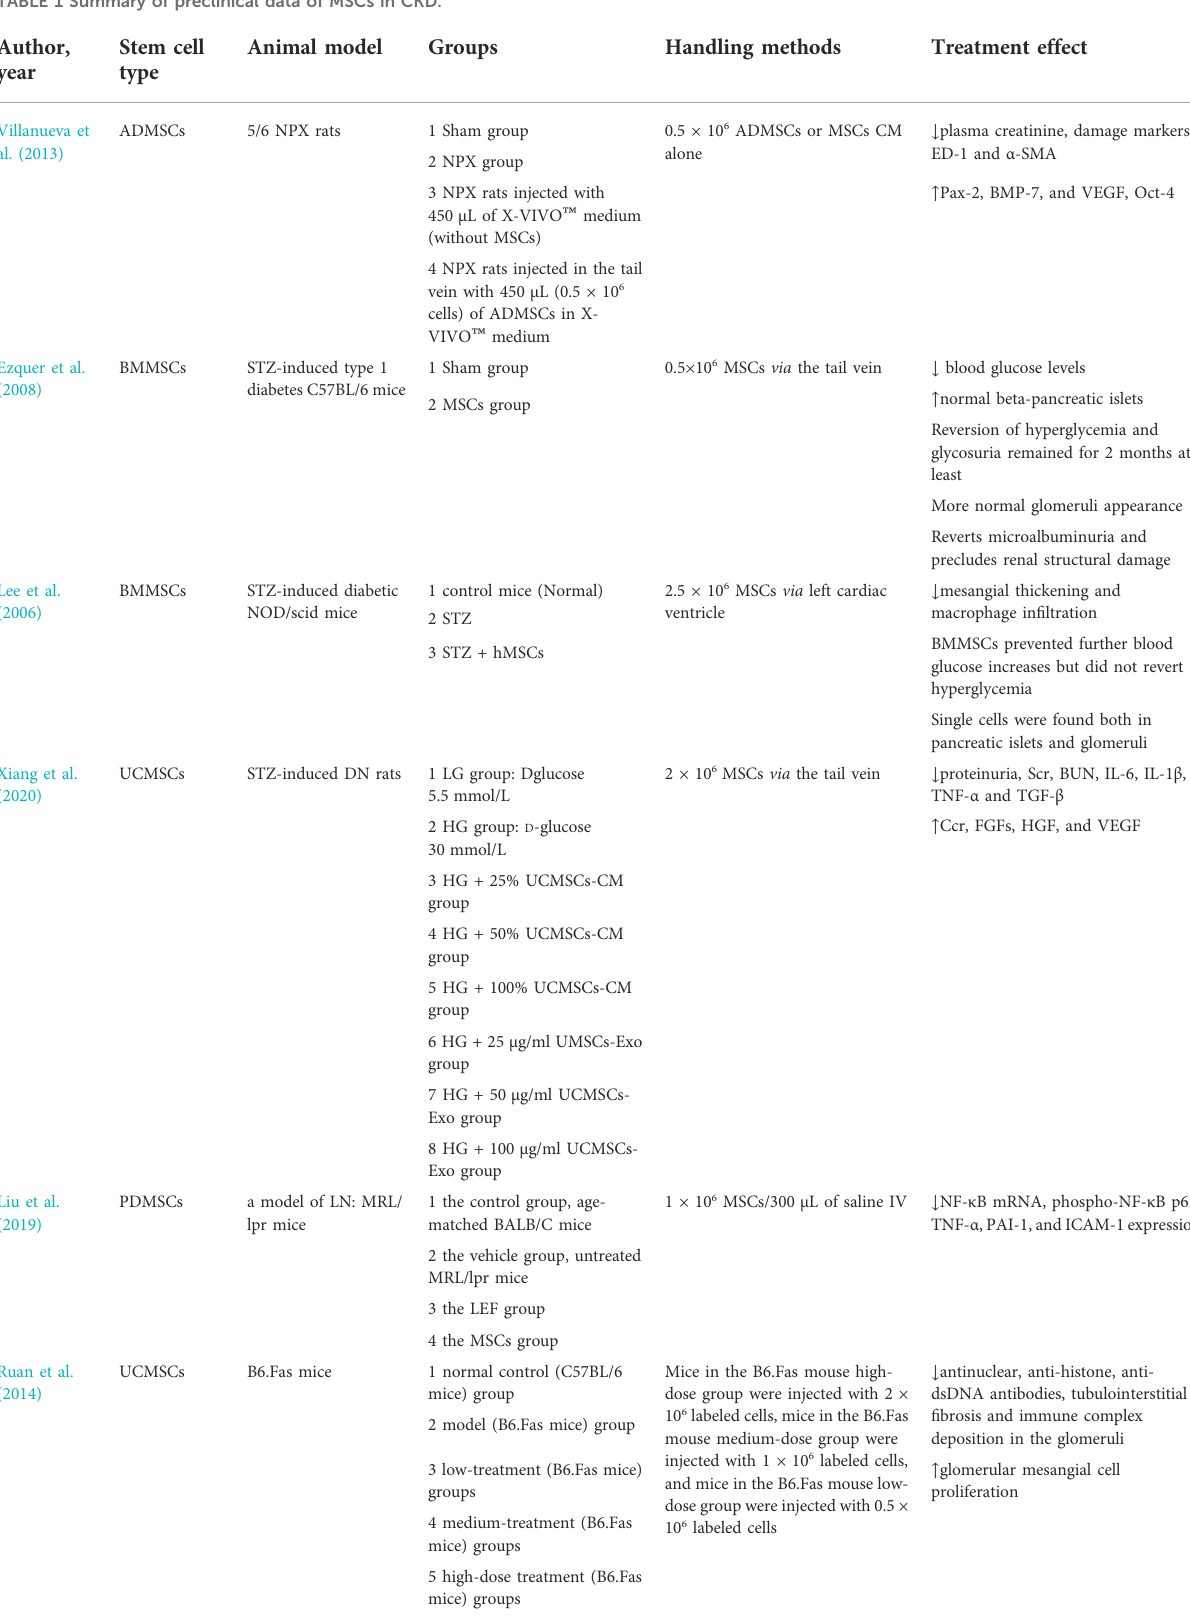
TABLE 1 Summary of preclinical data of MSCs in